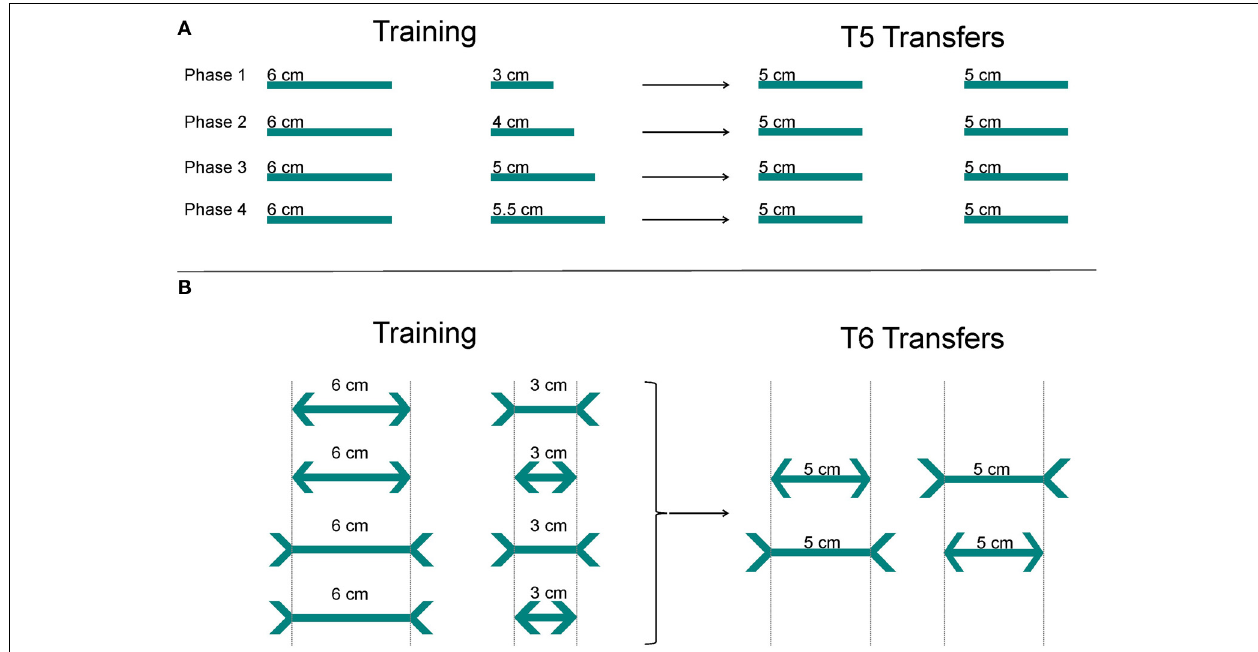
FIGURE 4 | Experiment 3. Shown are the stimuli presented to each group during the regular training and transfer test trials (3a and 3b). The positive, rewarded stimulus is marked by a checkmark. (A) In 3a, all sharks were trained to choose the longer of the two lines. In the T5 transfer tests, sharks were presented with two lines of equal length (5 vs. 5cm). (B) In the second part (3b), sharks were trained to choose